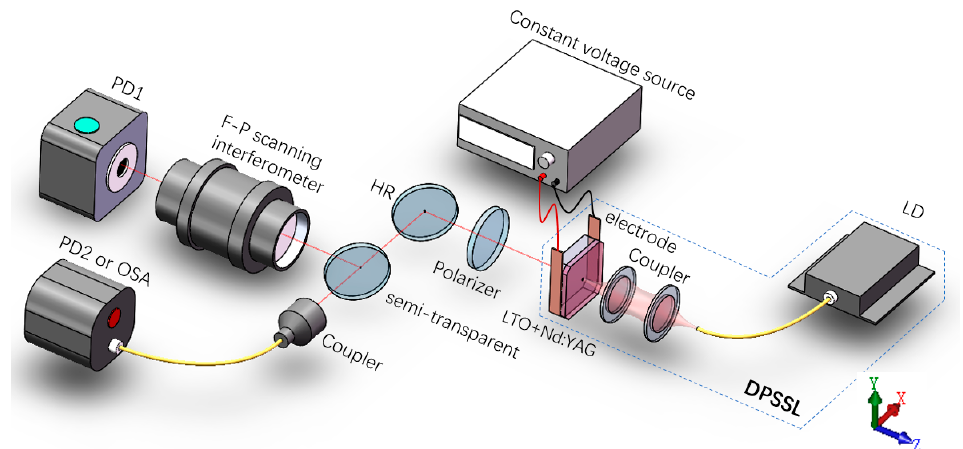
Figure 1. Schematic diagram of the experimental setup. LD, laser diode; HR, high-reflective mirror (@1064nm); PD, photoelectric detector; OSA, optical spectrum analyzer; DPSSL, diode-pumped solid-state